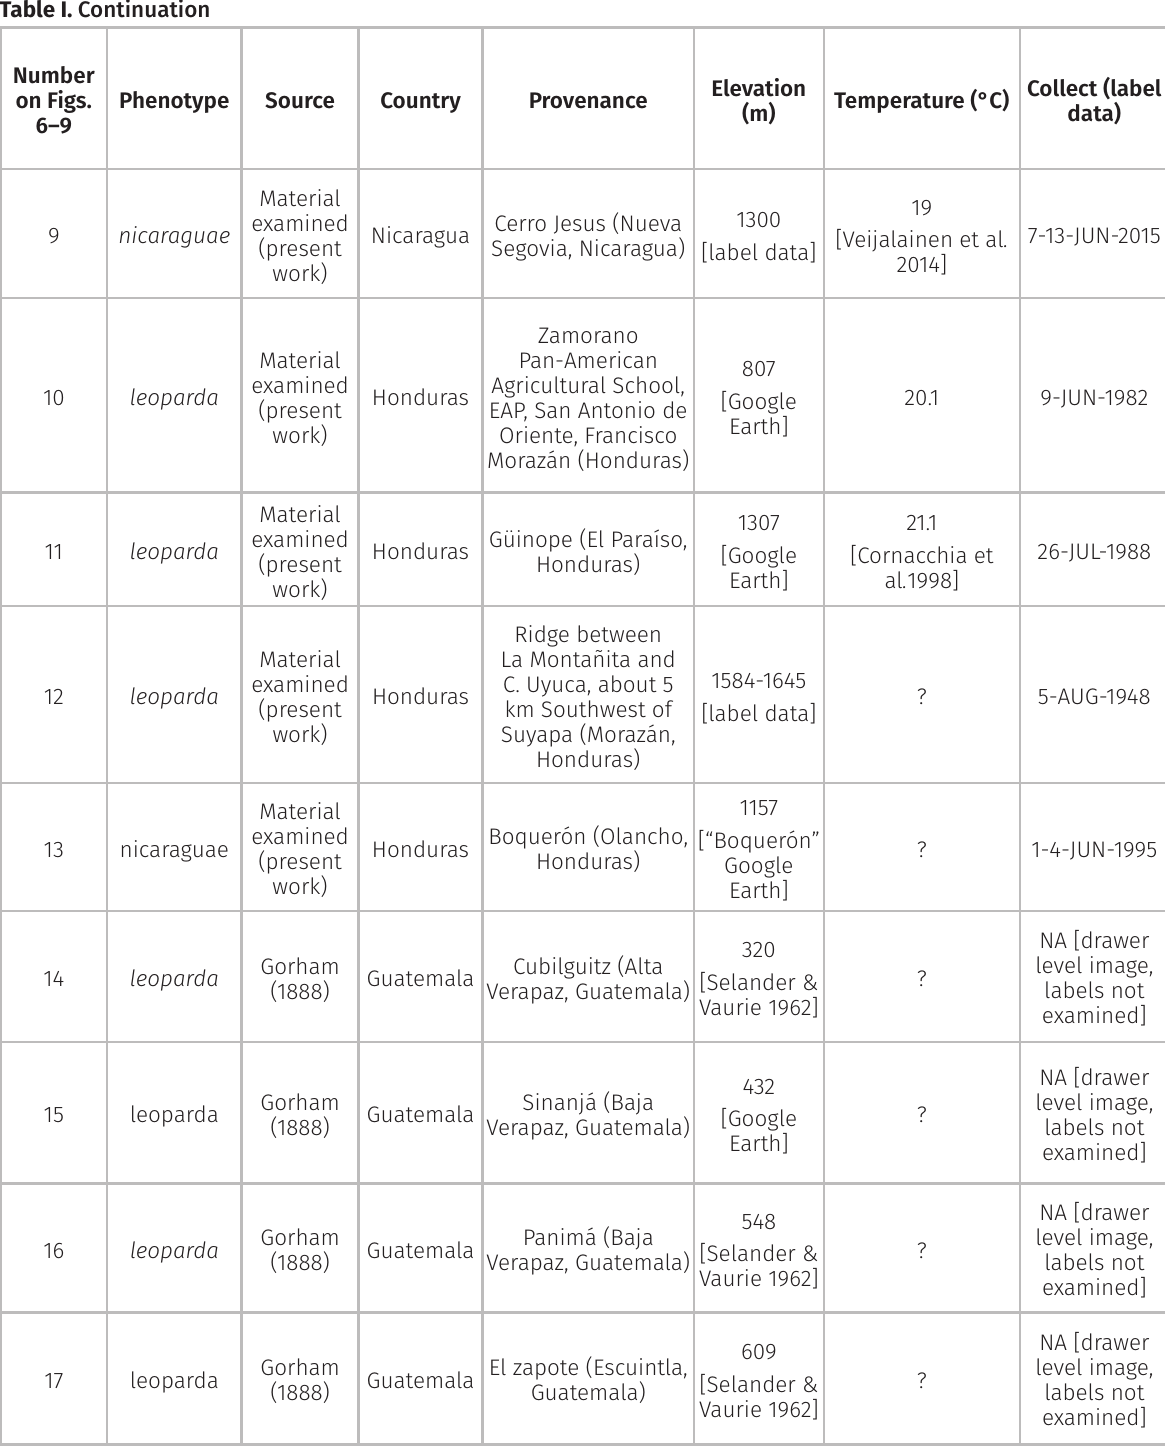
Table I. Continuation Number on